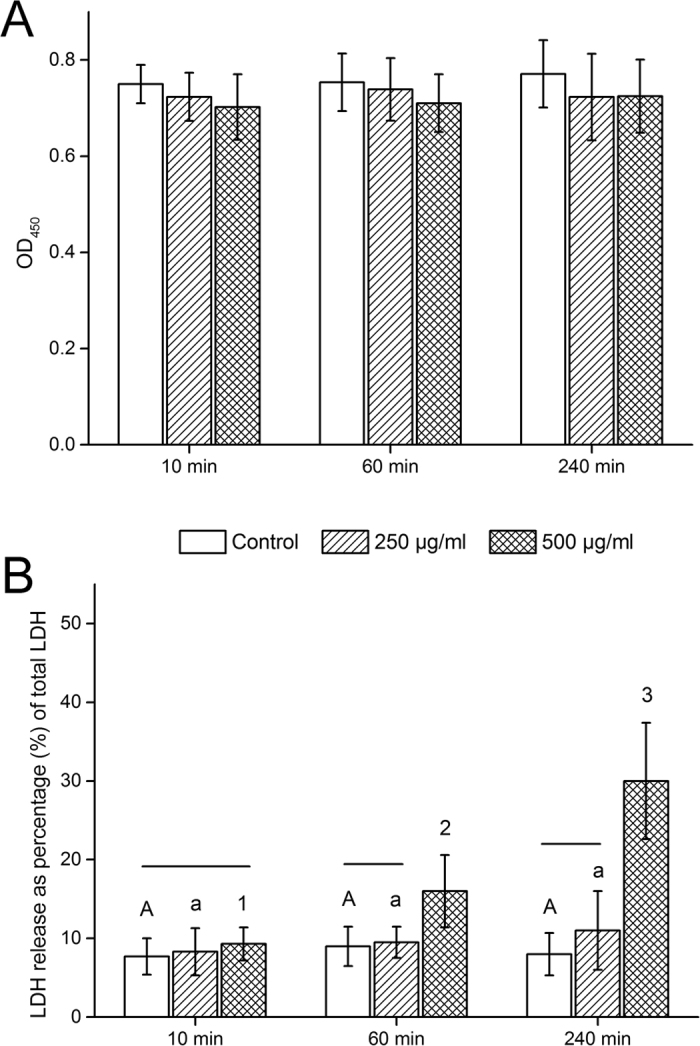
(A) Evaluation of the proliferation of HGFs treated with HBAMP at 250 and 500 μg/ml for 10, 60 and 240 min by CCK-8 assays. No difference was detected between all groups (P > 0.05). (B) Quantitation of lactate dehydrogenase (LDH) release of HGFs treated with HBAMP at 250 and 500 μg/ml for 10, 60 and 240 min by PierceTM LDH Cytotoxicity Assay Kit. For the factor “exposure time”, groups labelled with the same designators (upper case letters for control, lower case letters for 250 μg/ml, and numbers for 500 μg/ml) are not significantly different (P > 0.05). For the factor “HBAMP concentration”, groups from the same exposure time that are connected with a horizontal bar are not significantly different (P > 0.05).